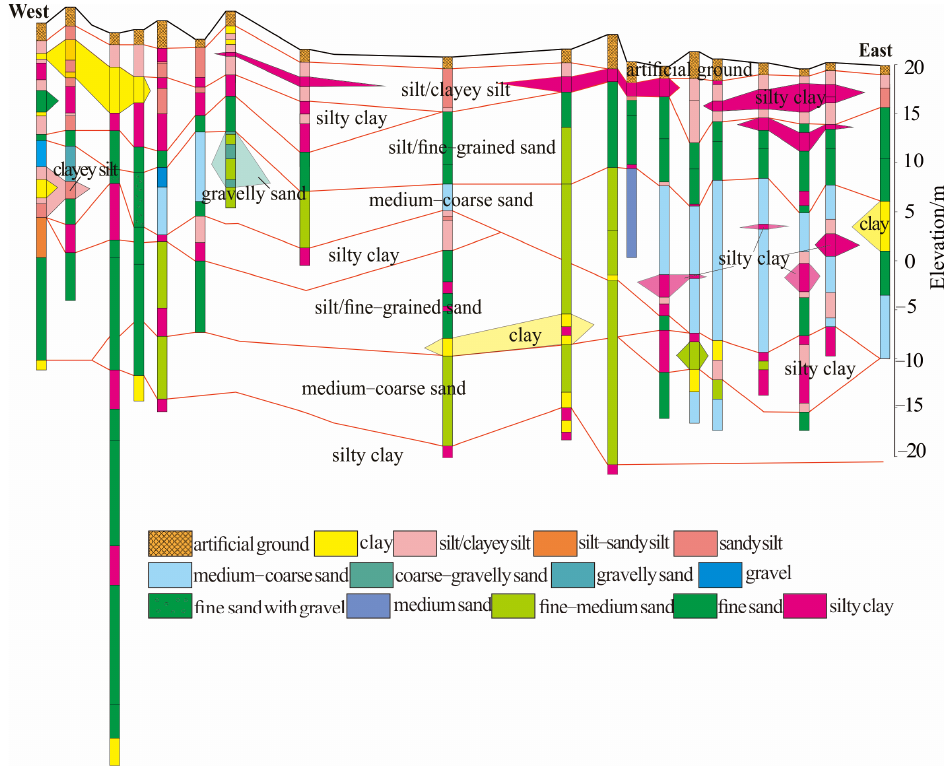
Figure 3. Original boreholes and stratigraphy were recorded along the WE08 cross-section line. (a) Data digitalization